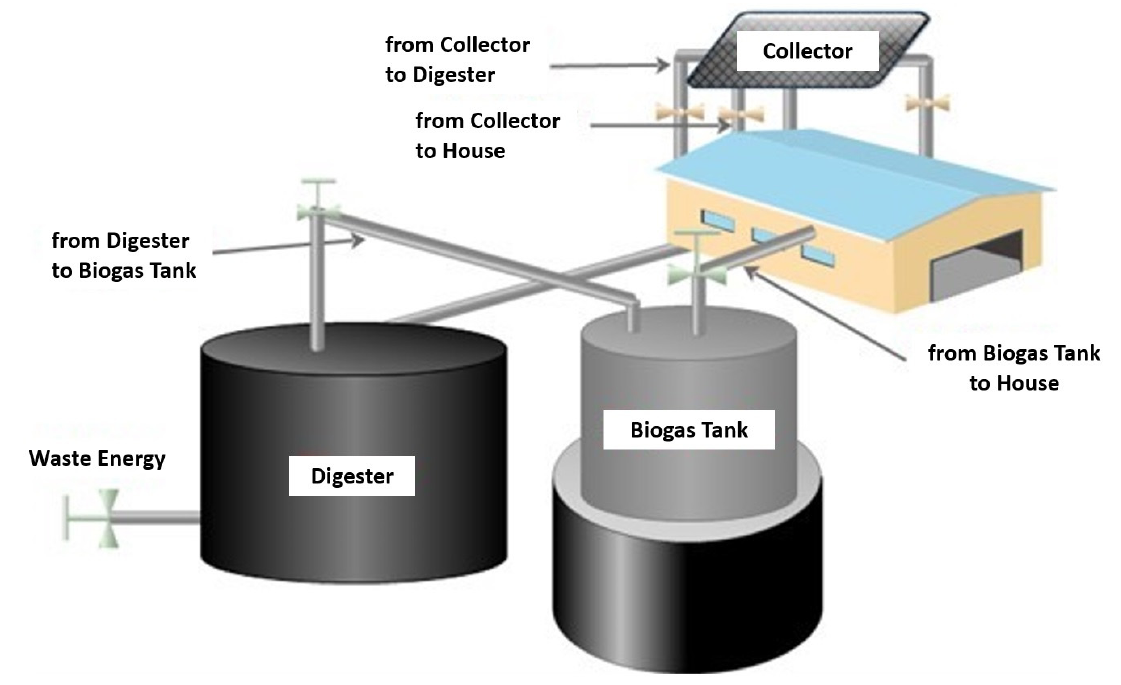
Figure 1. Bio-solar house system.